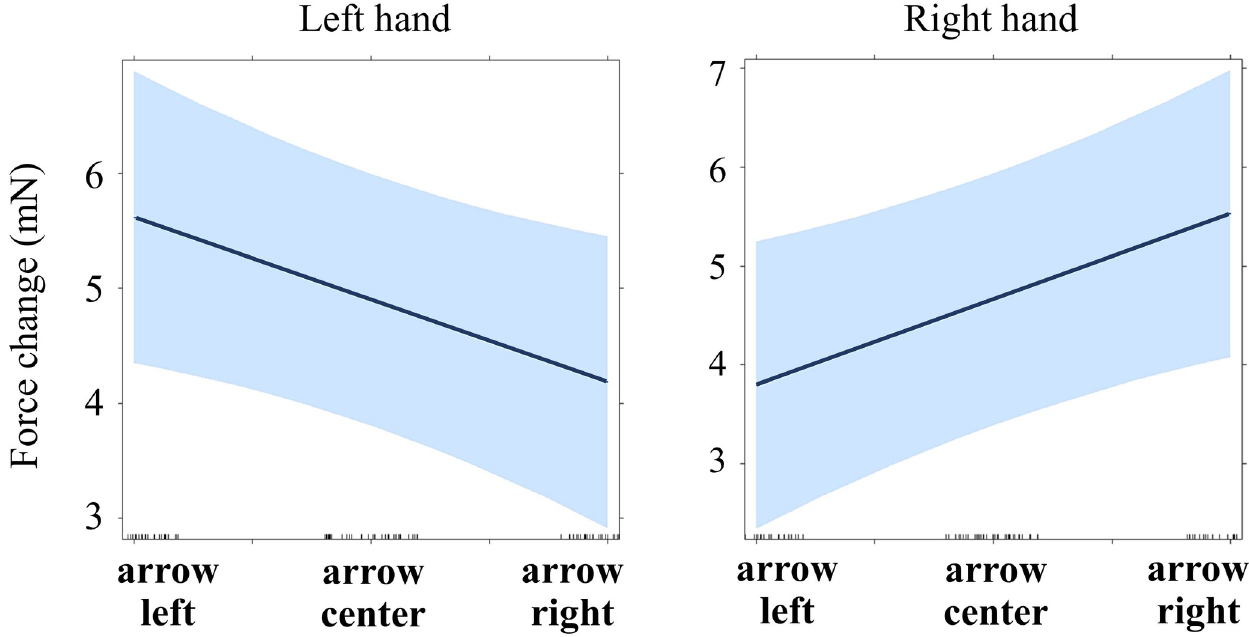
Fig 8. Regression lines for the main effect of arrow direction on force (Experiment 2, time window 100–150 ms). See main text for details (Models 2.3 and 2.4).